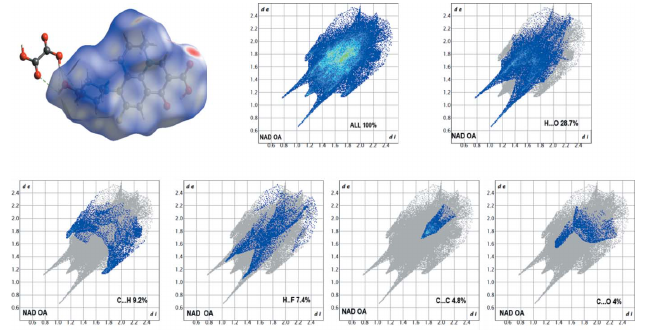
Figure 6 Two-dimensional fingerprint plots and relative contribution of various interactions to the Hirshfeld surface of the NAD molecule.